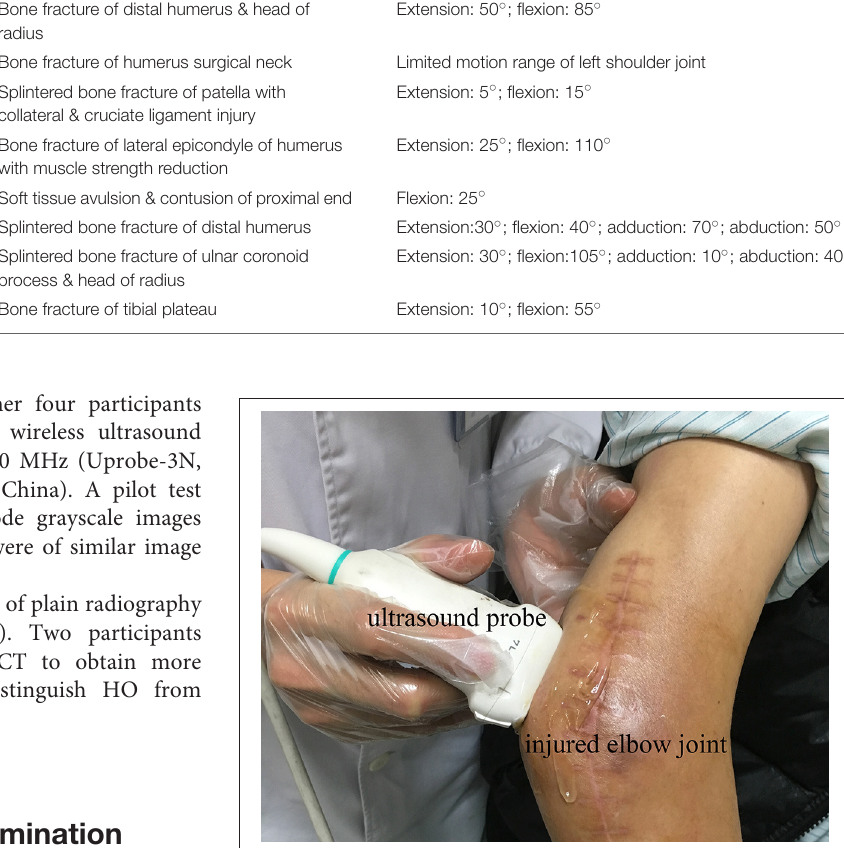
FIGURE 1 | Longitudinal ultrasound scanning of HO at the posteriorlateral site of the injured elbow joint of participant No.